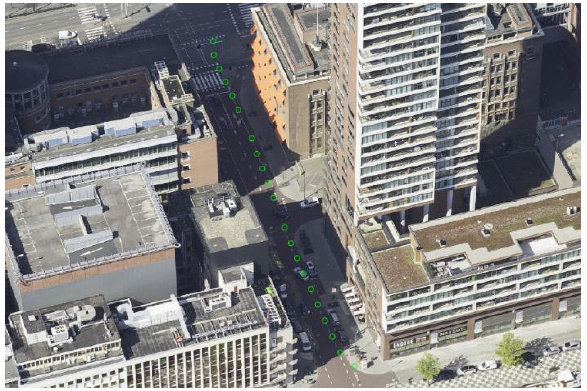
Figure 2. MM platform recording locations projected into aerial oblique